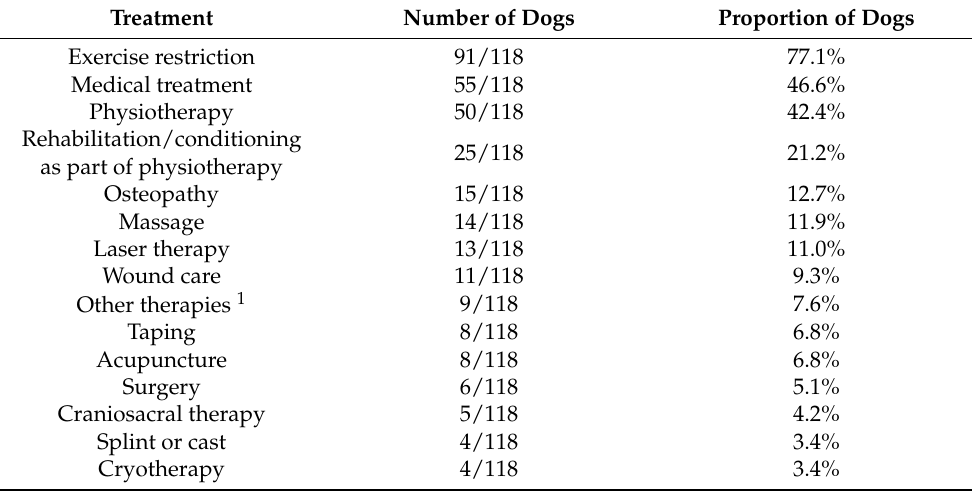
Table 6. Therapies and paraprofessionals used in treatment of agility-related injuries ( n =